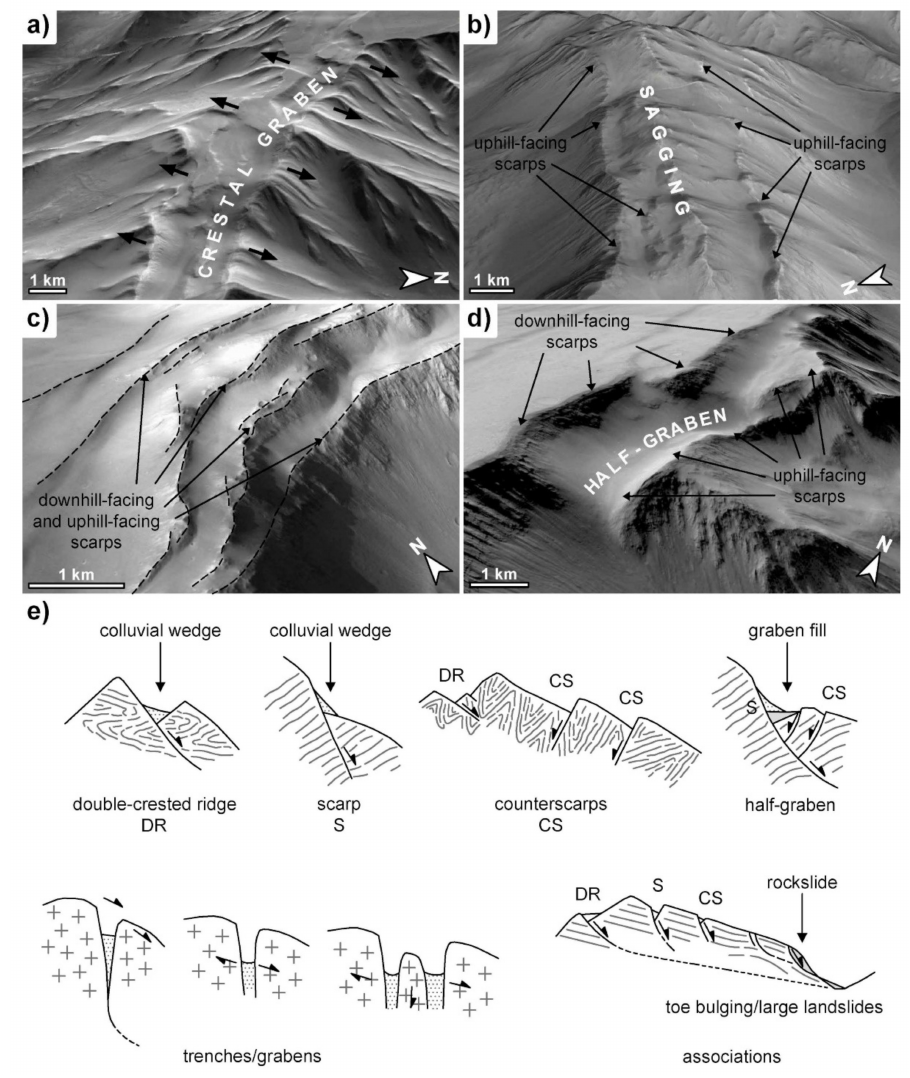
Figure 1. Examples of morphological features related to Deep-Seated Gravitational Slope Deforma- tions (DSGSDs) on Mars: ( a ) crestal graben along the ridge at Candor-Ophir boundary; ( b ) sagging of crest line due to opposite systems of uphill-facing scarps along the inner ridge of Candor Chaos; ( c ) multiple scarps transverse to the ridge of the Melas-Candor boundary, downhill-facing along the southern margin and uphill-facing along the northern margin; ( d ) half-graben in the upper sector of the western slope of Hebes Chasma, defined by downhill- and uphill-facing scarps; ( e ) morpho-structural features characteristics of DSGSDs, redrawn after Agliardi et al. [15]. Locations of ( a – d ) are reported in Figure 6. All the Mars images were produced with Google Mars based on the MOLA gridded elevation data and CTX